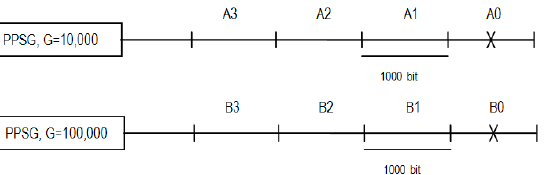
Figure 8. Derivation of groups A and B of bit sequences with a length of 1000 bits for the subsequent formation of bit templates.